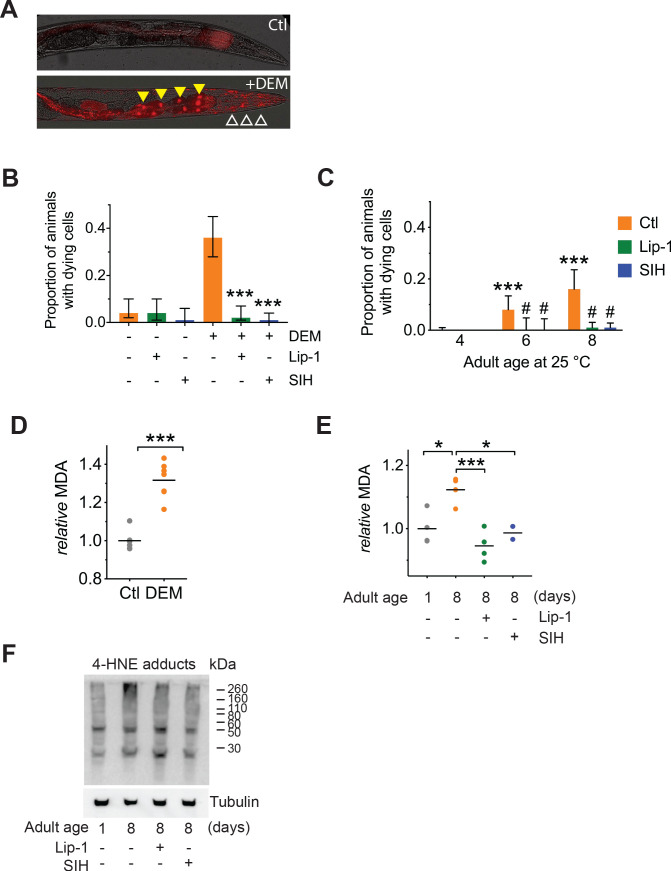
|Both Lip-1 and SIH inhibit cell death and protect against lipid peroxidation.Measures of lipid peroxidation and cell death show an increase with age and reduction by both Lip-1 and SIH treatment.In all panels, vehicle control (0.5% v/v DMSO, Ctl)-treated worms are shown in orange, Lip-1-treated (200 µM Lip-1) are green and SIH-treated (250 µM SIH) are blue. (A) Representative propidium iodide fluorescence (red) overlay of bright field micrograph depicting dead intestinal cells (marked by nuclear signal, yellow triangles) within a live Day 4 adult treated with DEM. Smaller fluorescent puncta were also observed, consistent with neuronal cell nuclei (white unfilled triangles). Untreated Day 4 adult control animals (Ctl) showed no cell death. (B) Proportion of live animals at Day 4 (±95% confidence intervals) of adulthood showing dead cell fluorescence (propidium iodide)±exposure to 10 mM DEM for 24 hr. Cohorts of animals included: co-treatment with a vehicle control (-DEM, Ctl, n = 102; +DEM Ctl n = 117), Lip-1 (-DEM, Lip-1, n = 84; +DEM Ctl n = 106) or SIH (-DEM, Ctl, n = 89; +DEM Ctl n = 129). Lip-1 and SIH both markedly reduced the proportion of animals with dead cells after DEM treatment (z-test: Ctl vs Lip-1 Z = 6.37 ***p<0.001; Ctl vs SIH Z = 7.24, ***p<0.001). (C) Proportion of live animals at 4, 6 and 8 days of adulthood (±95% confidence intervals) showing propidium iodide nuclear fluorescence. Day 6 Ctl adults (n = 160) had a significantly higher proportion of animals with dead cells than Day 4 Ctl (n = 263; z-test: Z = 4.70 ***p<0.001). Similarly, Day 8 Ctl adults (n = 119) had significantly higher prevalence of animals with propidium iodide nuclear fluorescence than Day 4 Ctl (z-test: Z = 6.65 ***p<0.001). No significant difference was observed between Day 6 and Day 8 control populations. Within the Day 6 adult cohorts treatment with Lip-1 (n = 77) or SIH (n = 81) markedly reduced the prevalence of animals with propidium iodide nuclear fluorescence compared to vehicle control (z-test: Ctl vs Lip-1 Z = 2.57 # p<0.001; Ctl vs SIH Z = 2.64, # p<0.001). Within the Day 8 adult cohorts treatment with Lip-1 (n = 234) or SIH (n = 308) markedly reduced the prevalence of animals with propidium iodide nuclear fluorescence compared to vehicle control (Ctl, n = 119; z-test: Ctl vs Lip-1 Z = 5.67 # p<0.001; Ctl vs SIH Z = 6.28, # p<0.001). (D) Levels of the lipid peroxidation end product malondialdehyde (MDA) increases in C. elegans following acute glutathione depletion by 20 mM DEM exposure for 6 hr. MDA levels are shown as values normalized against the mean of untreated Day 4 Adults (Ctl) for independent samples. (Ctl vs +DEM, unpaired 2-tailed t-test ***p<0.001) (E) Malondialdehyde (MDA) increases in aged C. elegans (Day 1 vs Day 8 adults, ANOVA *p<0.05). Treatment with either Lip-1 (Day 8 vs Day 8 +Lip-1 adults, ANOVA ***p<0.001) or SIH (Day 8 vs Day 8 +SIH adults, ANOVA *p<0.05) reduces levels of MDA. Data represent independent samples with values normalized against the mean of untreated Day 1 adults. (F) Representative immunoblot against 4-HNE protein adducts comparing Day 1 and Day 8 control adults and aged adults treated with Lip-1 and SIH with corresponding tubulin blot below (representative of triplicate experiments). The relative intensity of the bands show an age-related increase that is ameliorated by Lip-1 and SIH.Figure 2—source data 1.Data for cell death and lipid peroxidation.